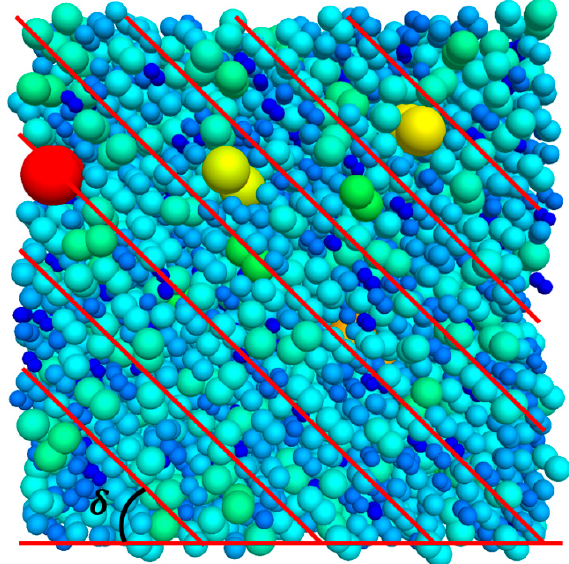
Figure 4. Generating initial anisotropic specimens.